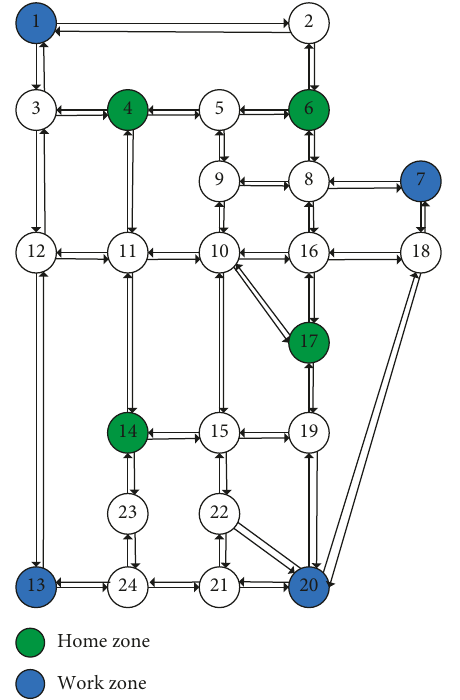
Figure 14: The Sioux Falls network.